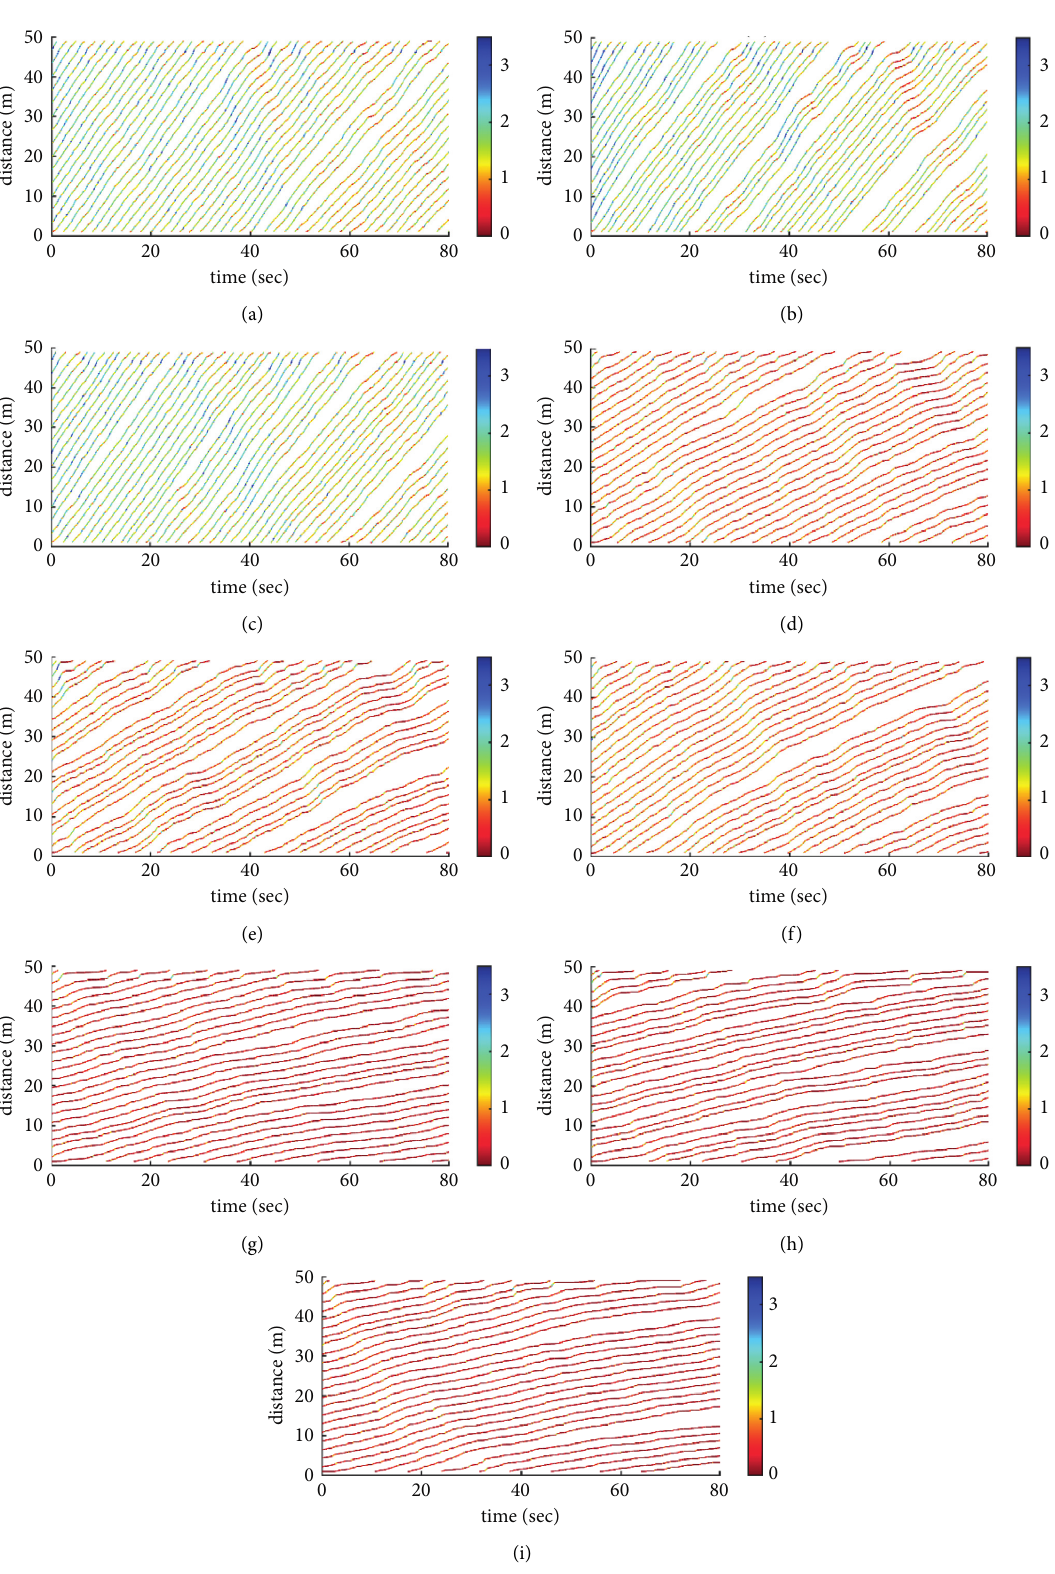
Figure 8: Each bicycle’s trajectory in Case IV under different N . (a–c) Left lane, (d–f) middle lane, and (g–i) right lane. (a) N � 15. (b) N � 15. (c) N � 15. (d) N � 19. (e) N � 19. (f) N � 19. (g) N � 23. (h) N � 23. (i) N �